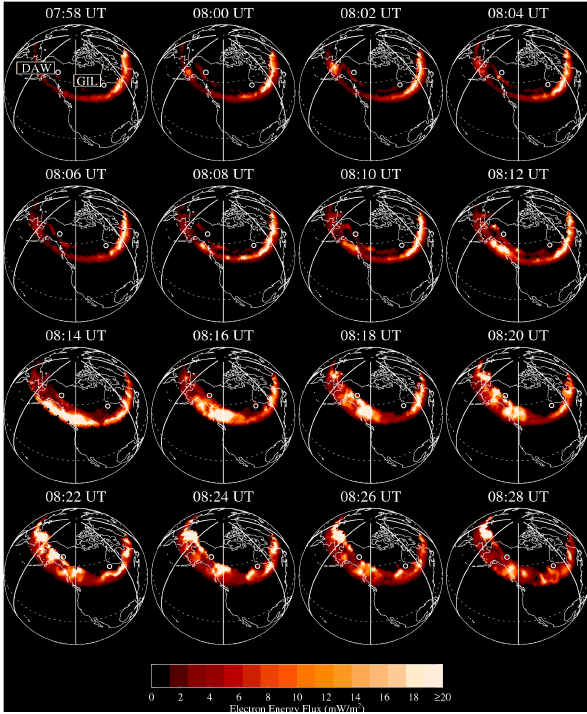
Fig. 11. Maps of Northern Hemisphere FUV emission converted to electron energy flux (mW/m 2 ) recorded by the camera on board the IMAGE satellite on 18 April 2002. These cover the onset of substorm B from 05:22 UT to 05:53 UT.